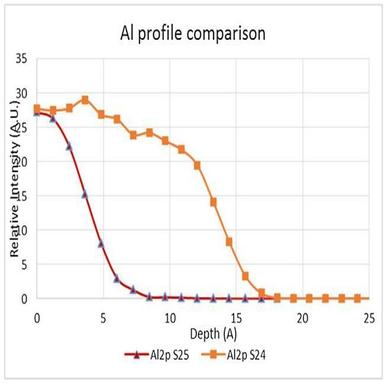
Comparison of Al profile in S25 and S24.